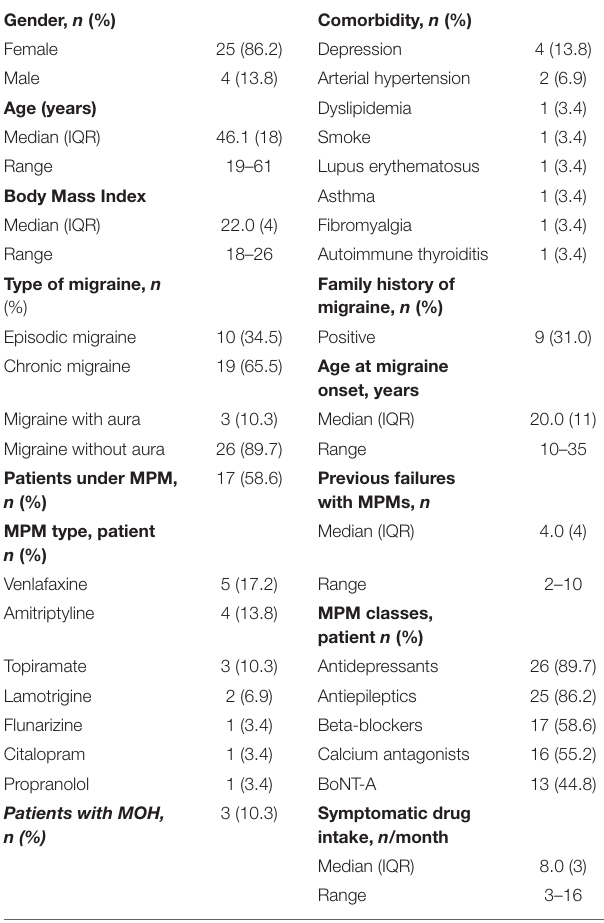
TABLE 2 | Main baseline demographic and clinical characteristics of patients ( n =